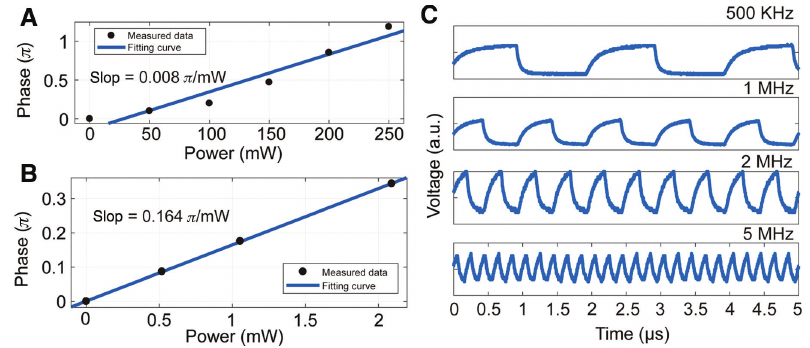
Figure 4: Phase shift and dynamic response of the modulator. (A) Phase shift results when illuminating different powers of the 980-nm pump light from outside. (B) Phase response of different powers of the 1550-nm band pump light from the waveguide. (C) Measured waveforms of the probe light when the pump light is modulated with a square waveform signal at different